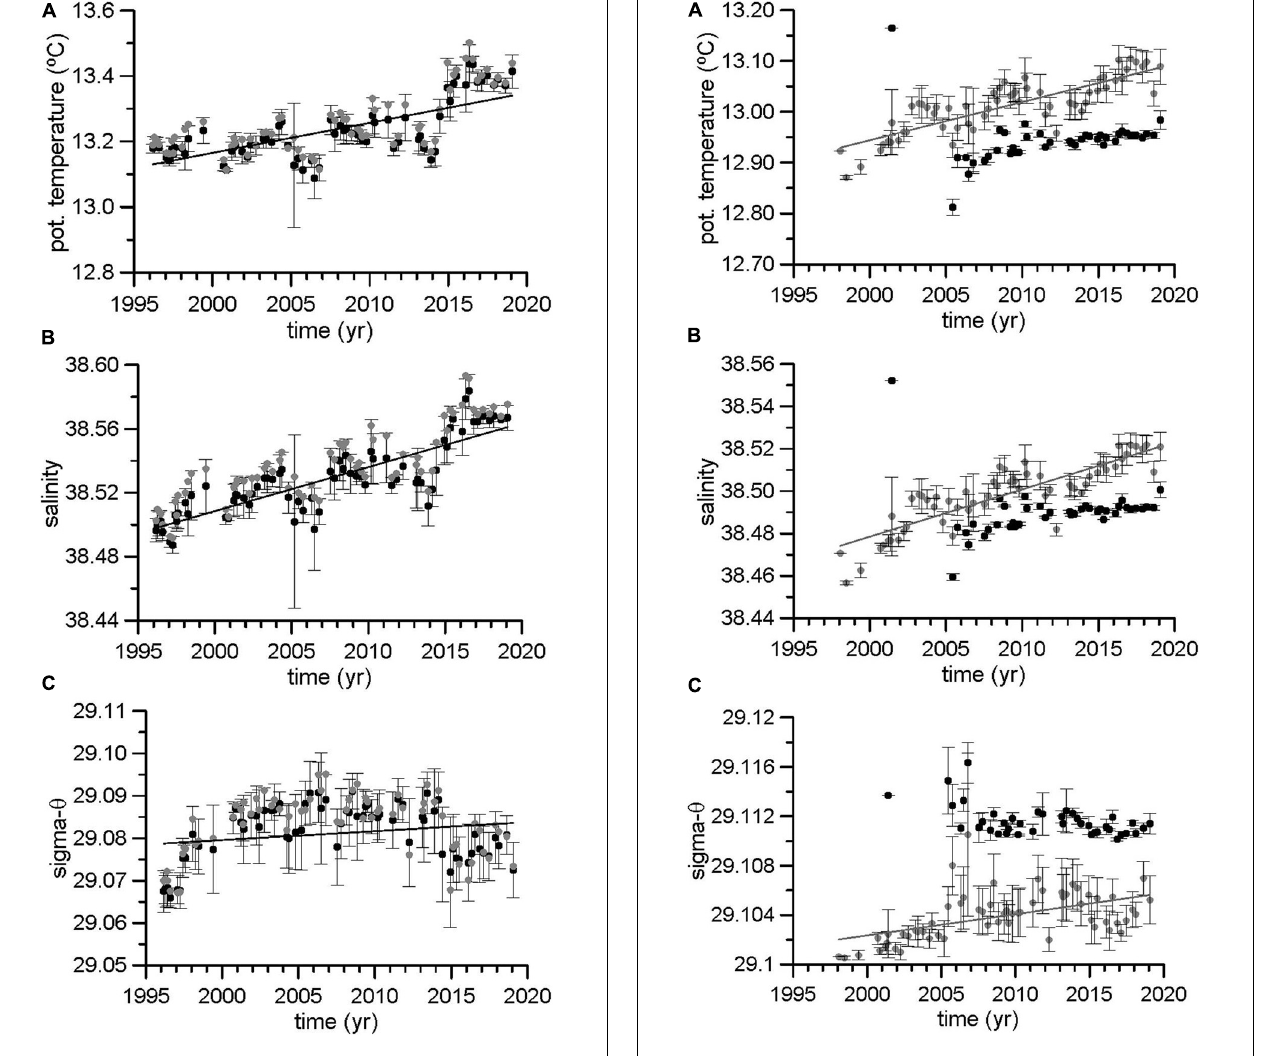
FIGURE 5 | Time series of potential temperature (A) , salinity (B) , and potential density (C) for the LIW. Black dots and error bars (one standard deviation) correspond to the LIW properties obtained using method 1, and gray dots correspond to the properties obtained using method 2.